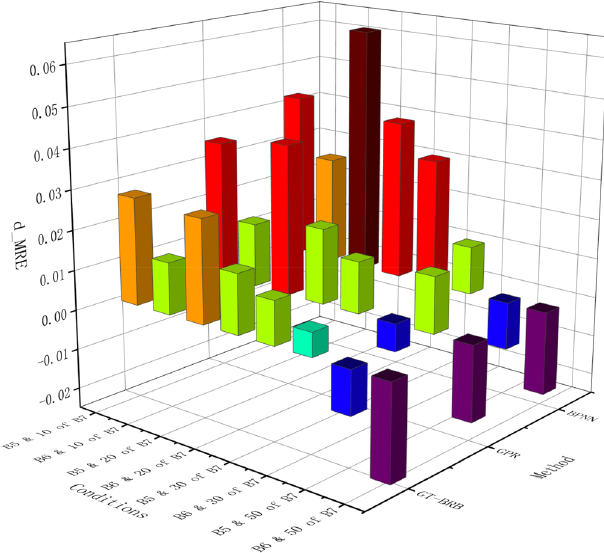
Fig. 9 The d_MRE of different